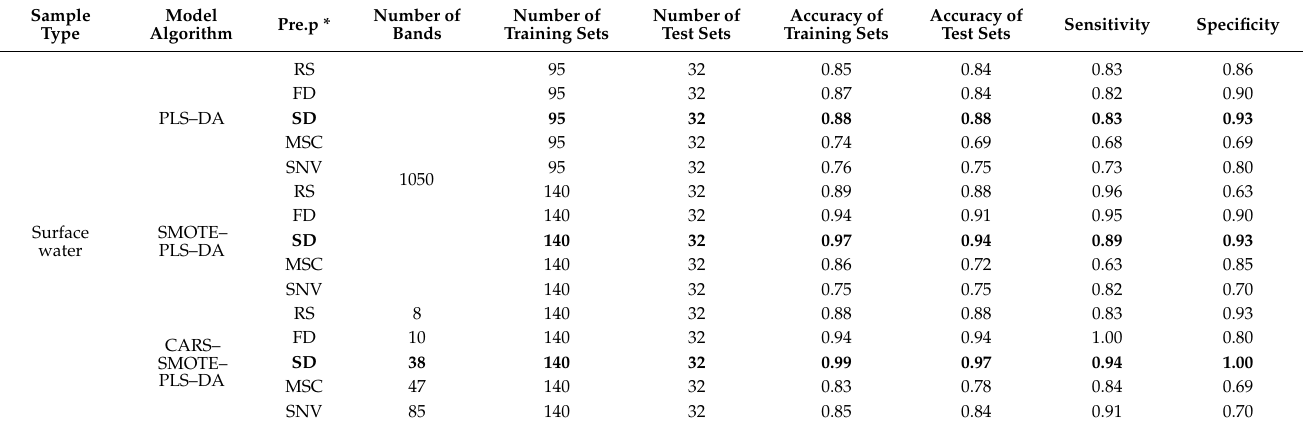
Table 2. Summary of discrimination results of partial least squares discriminant analysis